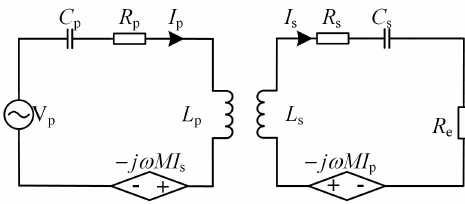
Figure 3. Equivalent mutual inductance model of serial–serial (SS) compensated